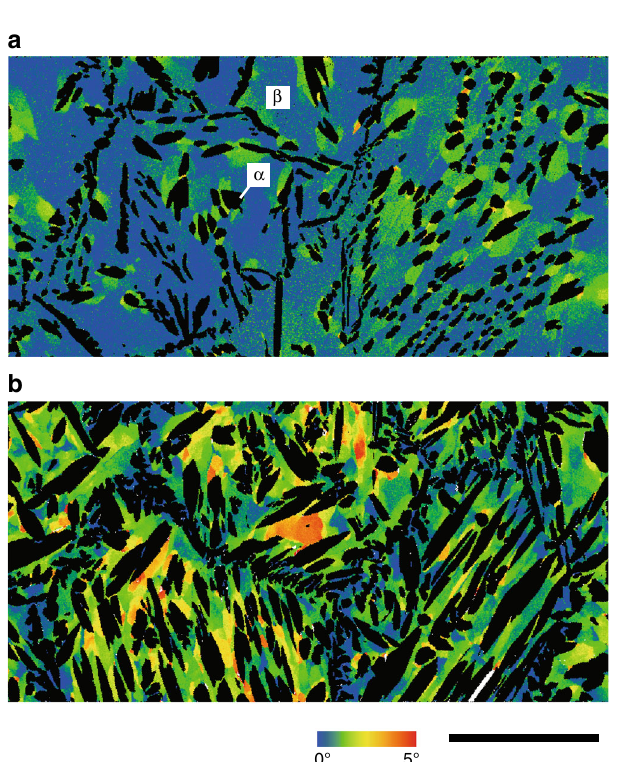
Fig. 5 Microstructure of Cu-Al-Mn alloy subjected to slow cooling to the α + β two-phase region. Grain reference orientation deviation (GROD) mapping of Cu-Al-Mn alloy cooled to a 650 °C and b 500 °C. Scale bar , 500 μ m. The heat treatment is shown in Supplementary Fig. 4f